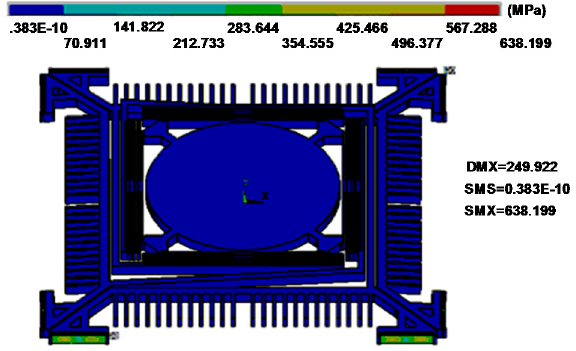
Figure 4. Stress distribution with a ±250 μ m out-of-plane vertical displacement. Maximum stress of ~638.2 MPa is found near the fixed end of the H-shaped torsional spring.